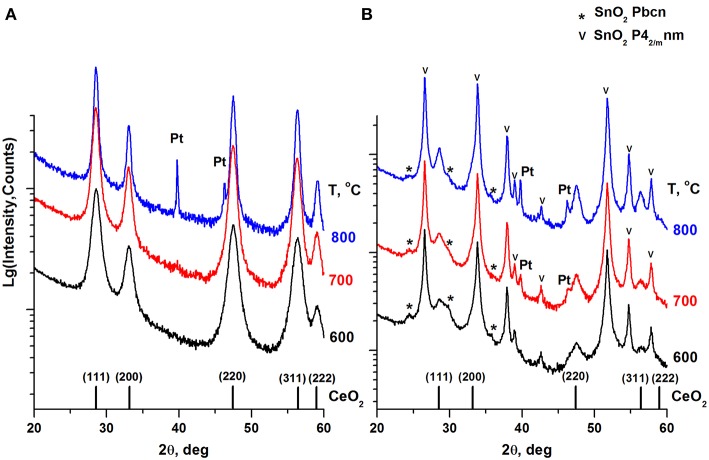
XRD patterns of the Pt/Ce (A) and Pt/CeSn (B) samples calcined at different temperatures. The graph at the bottom shows the positions of CeO2 fluorite phase reflections and corresponding Miller indexes. Symbol (*) indicates an unstable orthorhombic form of SnO2, the symbol (v) indicates reflections of a cassiterite SnO2 phase.